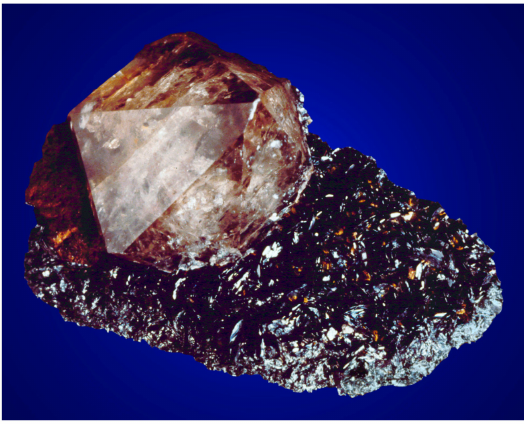
Figure 8. Quartz and hematite, Dodge mine. 5.2 cm. Chamberlain Collection, NYSM C5010.